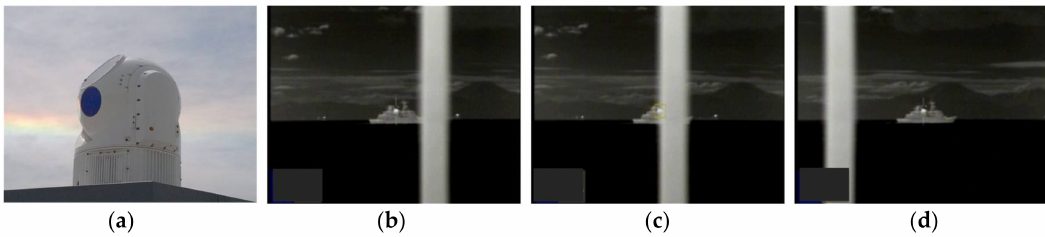
Figure 23. Result of application for naval EOTS: ( a ) shape of naval EOTS ( b – d ) operational images of testing coast mode tracking.